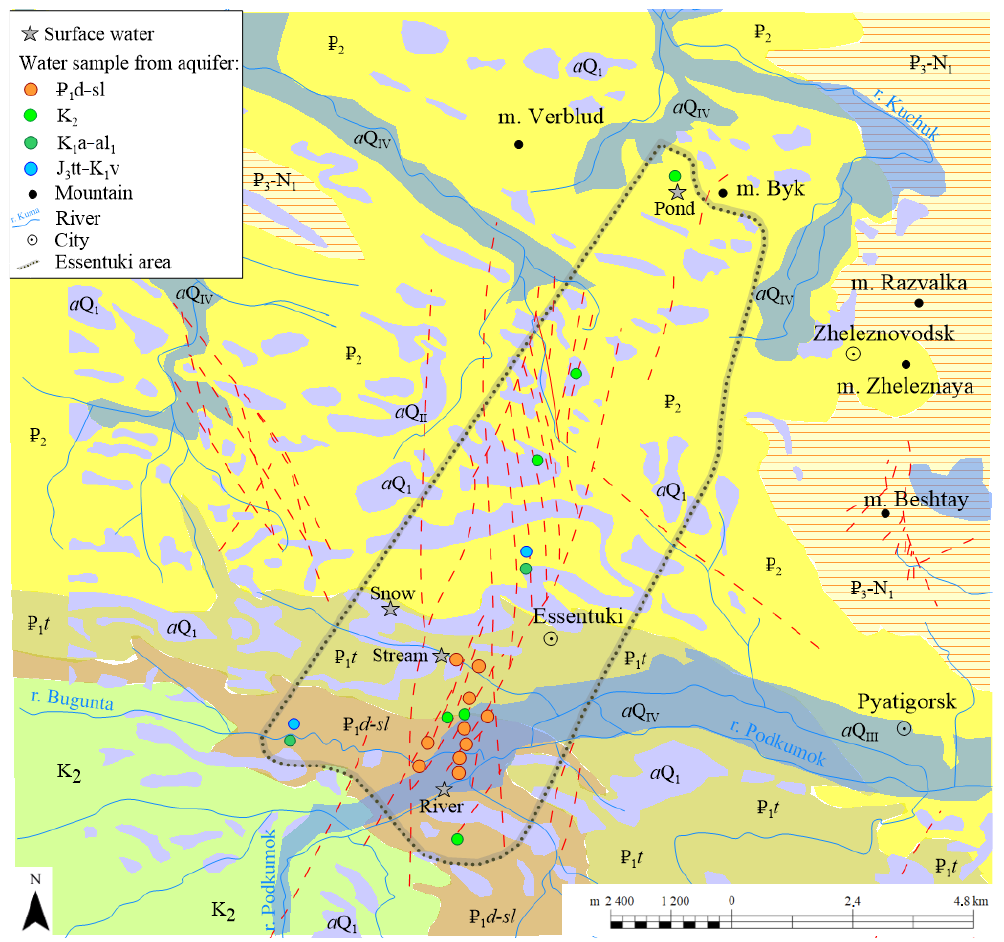
Figure 2. Geological map of the study area.